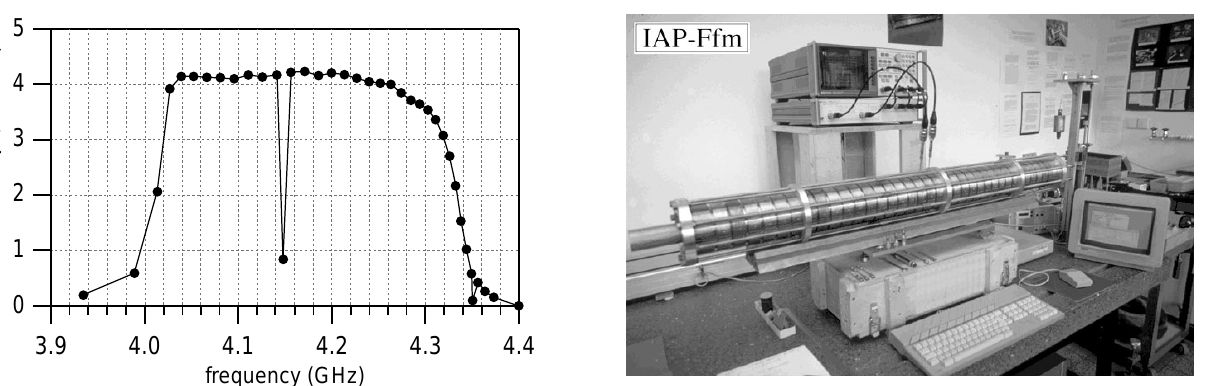
FIG. 4. Loss factor for the first dipole passband calculated with MAFIA .